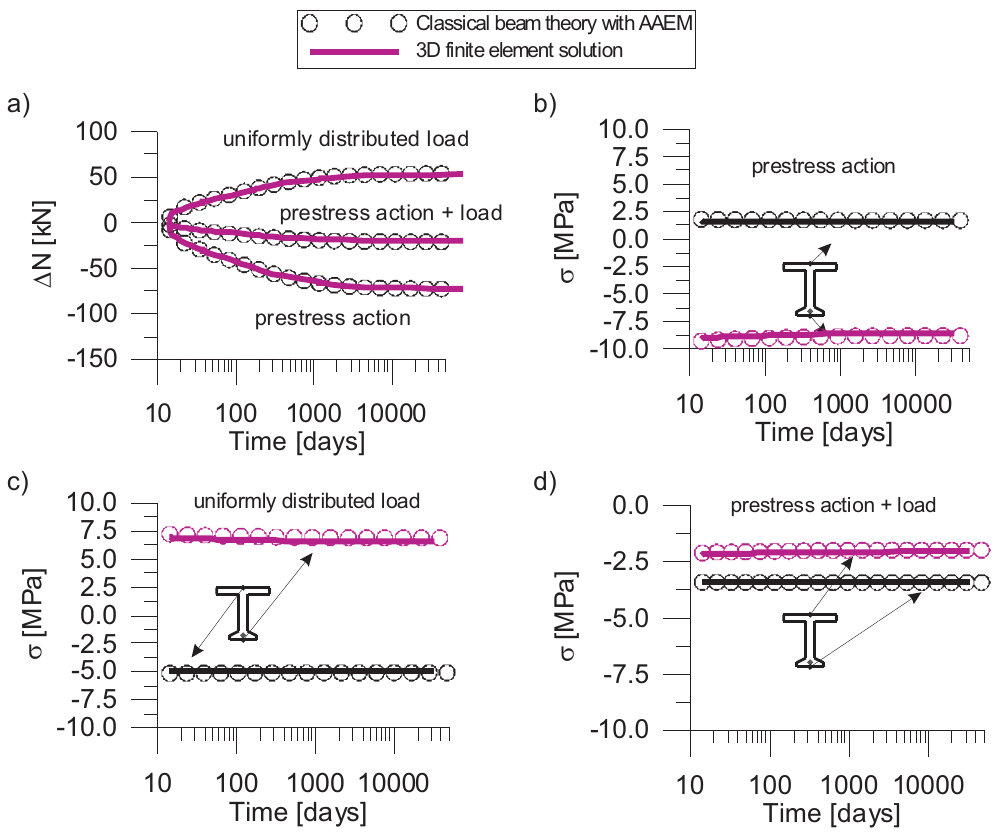
Figure 6. ( a ) Evolution of the force in the prestress steel tendon for different loading conditions; ( b – d ) evolution of the normal stresses in the middle-span cross-section for the prestress action only, external distributed load only, and their combination,